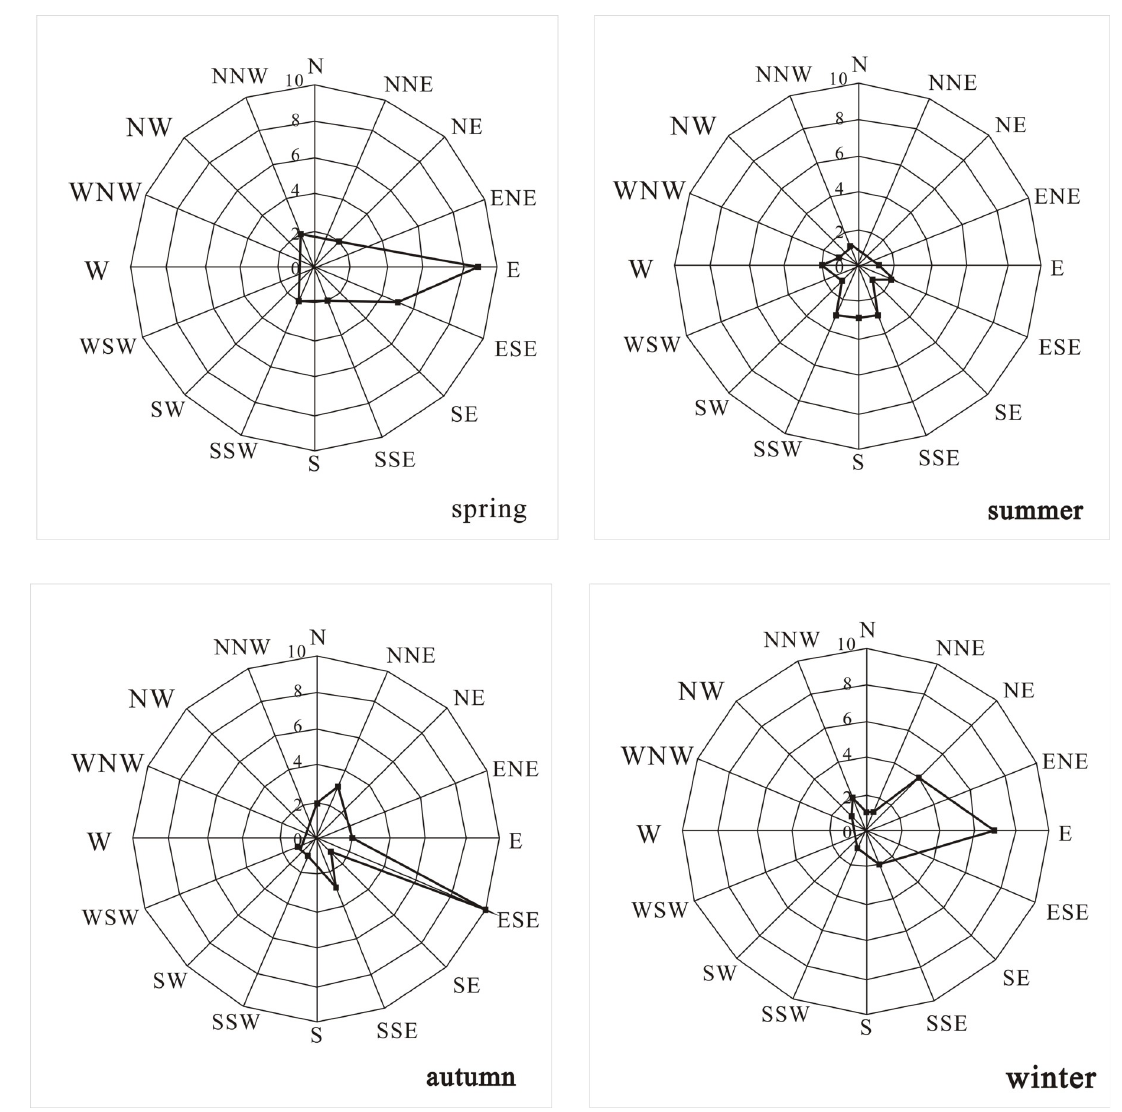
Fig 6. Frequency of wind directions in different seasons in central Zhanjiang city during